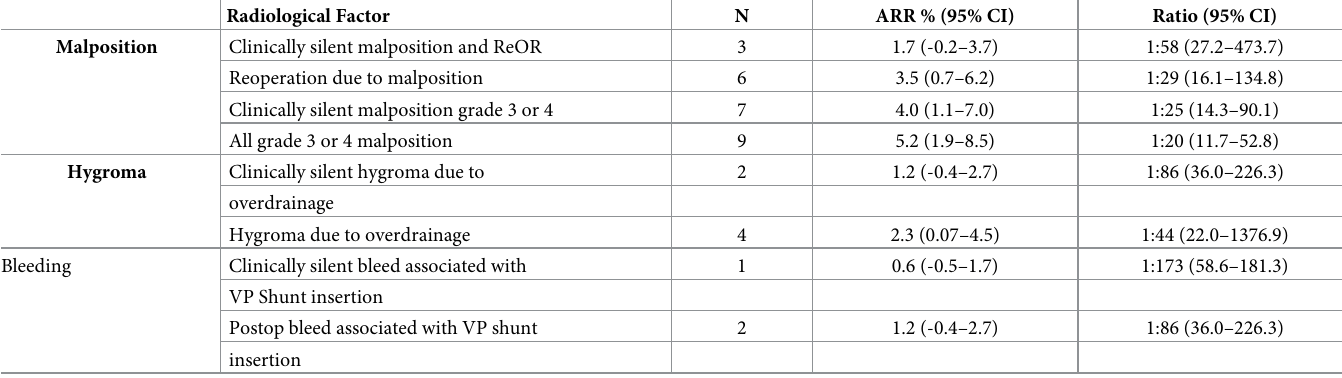
Table 4. Absolute risk reduction (ARR) and diagnostic ratio for early postoperative cranial CT of various radiological factors.